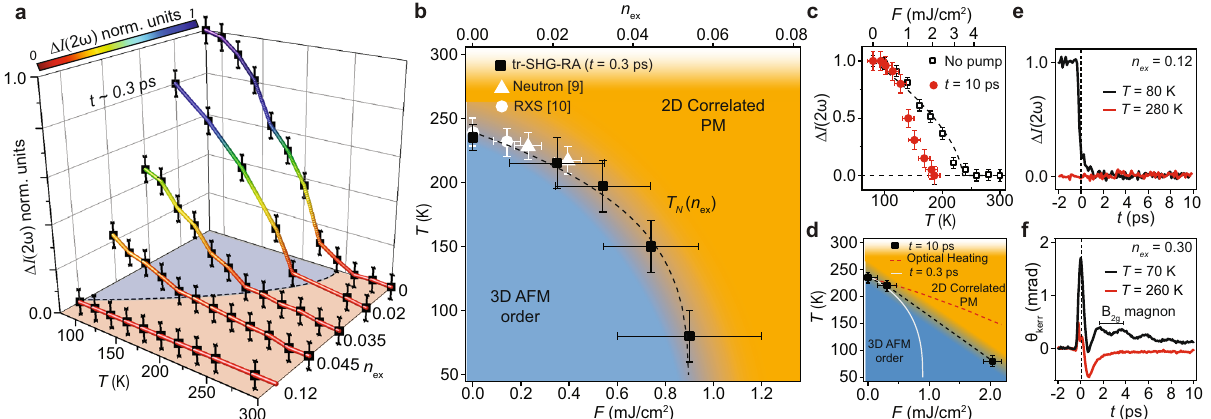
Fig. 2 Out-of-equilibrium magnetic phase diagrams. a Temperature dependence of the change in second harmonic generation (SHG) intensity Δ I (2 ω ) at t = 0.3 ps, normalized to the un-pumped value at T = 80 K, for select pump excitation densities n ex . b Out-of-equilibrium phase diagram mapped at t = 0.3 ps by either sweeping T or n ex . Black squares mark the temperature onset of the surface magnetization-induced electric-dipole (SMIED) contribution at different fl uences, T N ( n ex ). Dashed curve and blue-orange background are guides to the eye. The reported La-doping dependence of T N is overlaid. c Comparison of the temperature dependence of Δ I (2 ω ) for an un-pumped sample with the fl uence ( F ) dependence of Δ I (2 ω ) collected at t = 10 ps and T = 80 K, where F is converted into an effective temperature by assuming all of the pump energy goes into quasi-equilibrium heating. Dashed curve is a guide to the eye. d Out-of-equilibrium phase diagram mapped at t = 10 ps (black squares). Dashed black line and blue-orange background are guides to the eye. Overlaid are the phase boundary reproduced from panel b (white line) and that calculated assuming all of the pump energy goes into quasi- equilibrium heating (red line). e High fl uence Δ I (2 ω ) and f magneto-optical Kerr effect transients acquired below and above T N . Vertical error bars in panels a , c represent the range of intensity values obtained upon selecting different regions of the CCD camera for radial integration and background subtraction in order to convert raw data into SHG-RA intensity patterns. Horizontal error bars in panels c , d represent the uncertainty in fl uence due to laser drift. Horizontal (vertical) error bars in panel b (panels b , d ) represent the uncertainty in our estimate of the critical n ex ( T N ( n ex